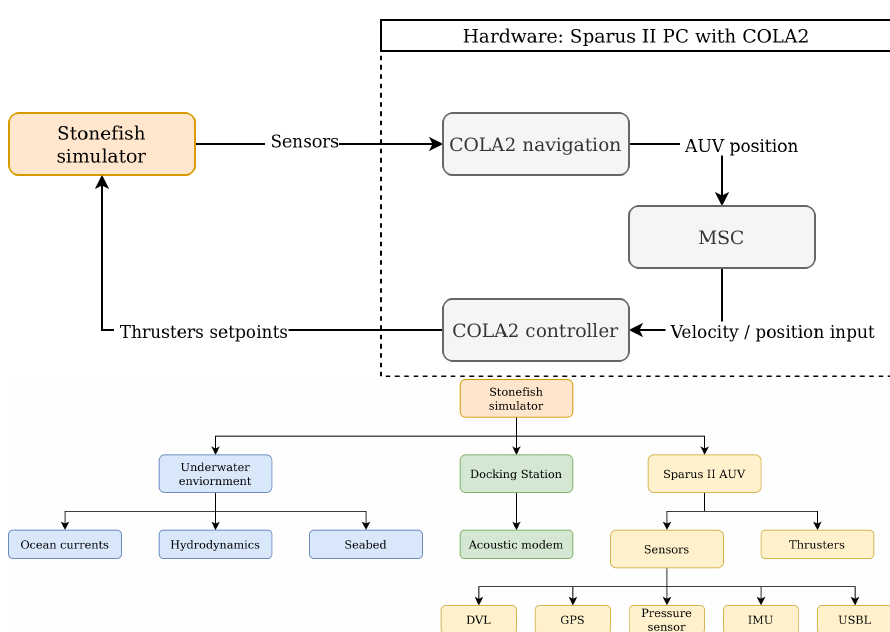
Figure 13. Conceptual representation of the hardware-in-the-loop simulation. The Sparus II